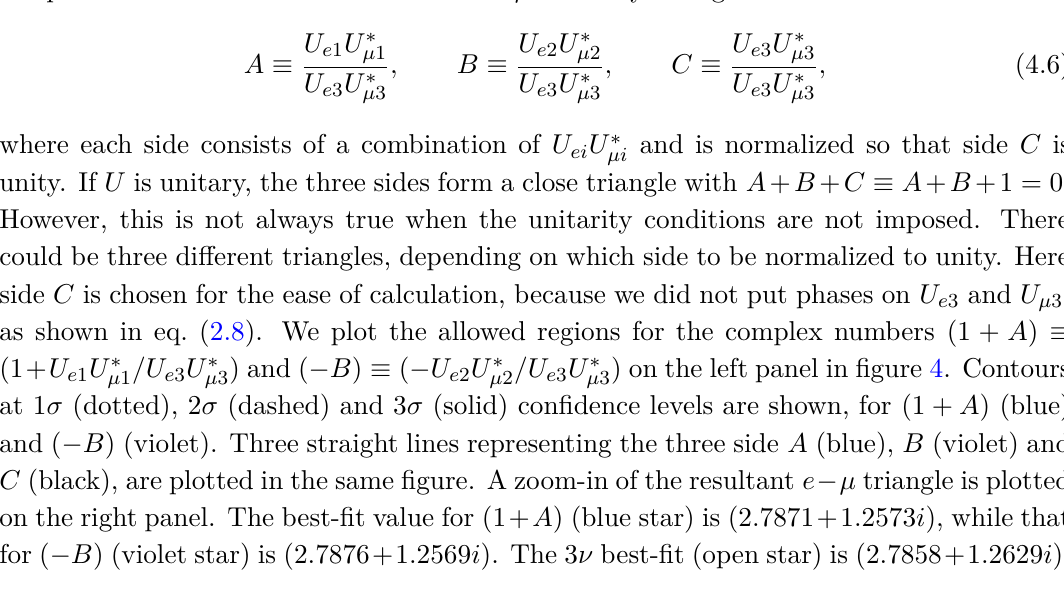
U ∗ ] (blue) and J eµ 13 ≡ = [ U e 1 U µ 3 U ∗ e 3 µ 2